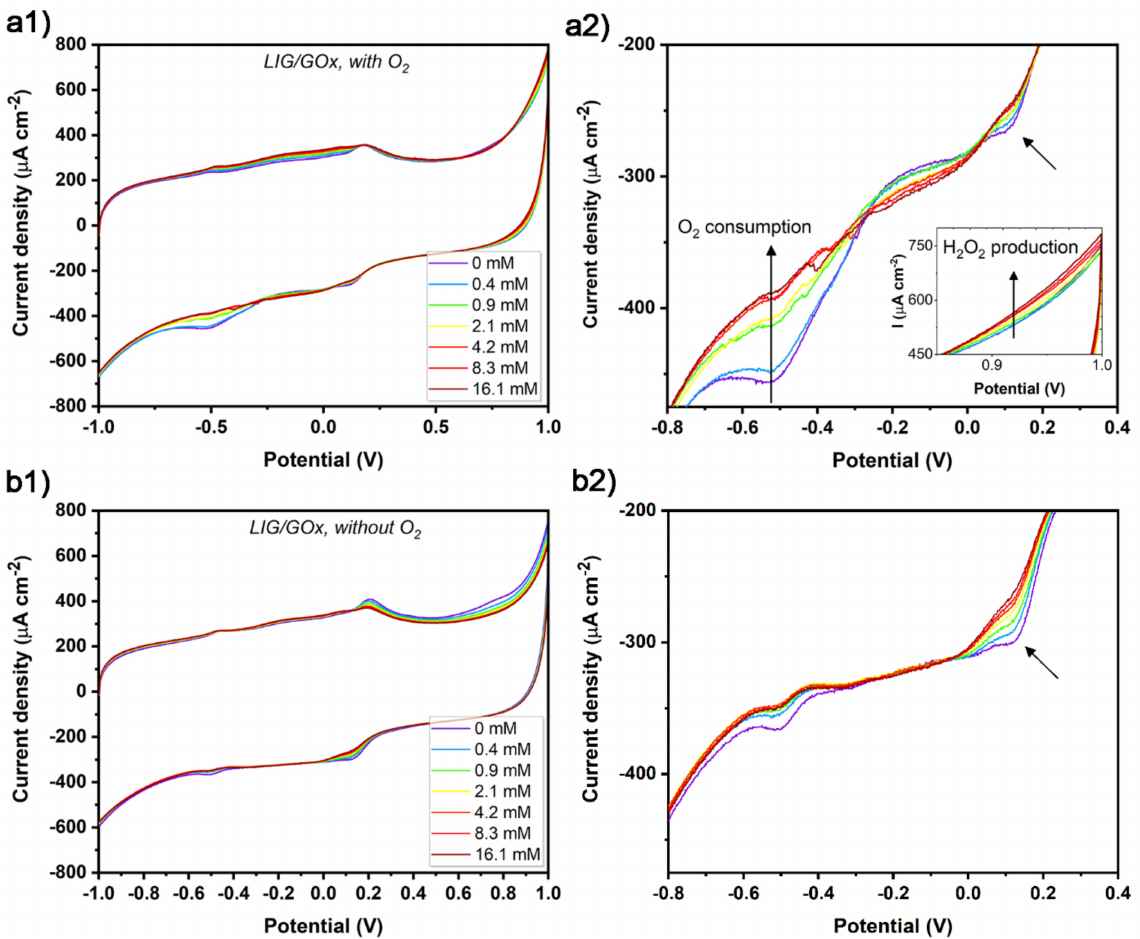
Figure 7. Cyclic voltammograms, from − 1.0 to 1.0 V at 100 mV s − 1 , of LIG/GOx ( a1 ) in the presence and ( b2 ) in the absence of O 2 , varying glucose concentration. Three cycles were recorded and only the third is displayed. All the measurements were performed in PBS (pH 7.4, 10 mM). ( a2 ) and ( b2 ) are magnifications of the cathodic region of the voltammograms displayed in ( a1 ) and ( b1 ), respectively. The inset in ( a2 ) presents the potential region where H 2 O 2 electro-oxidation